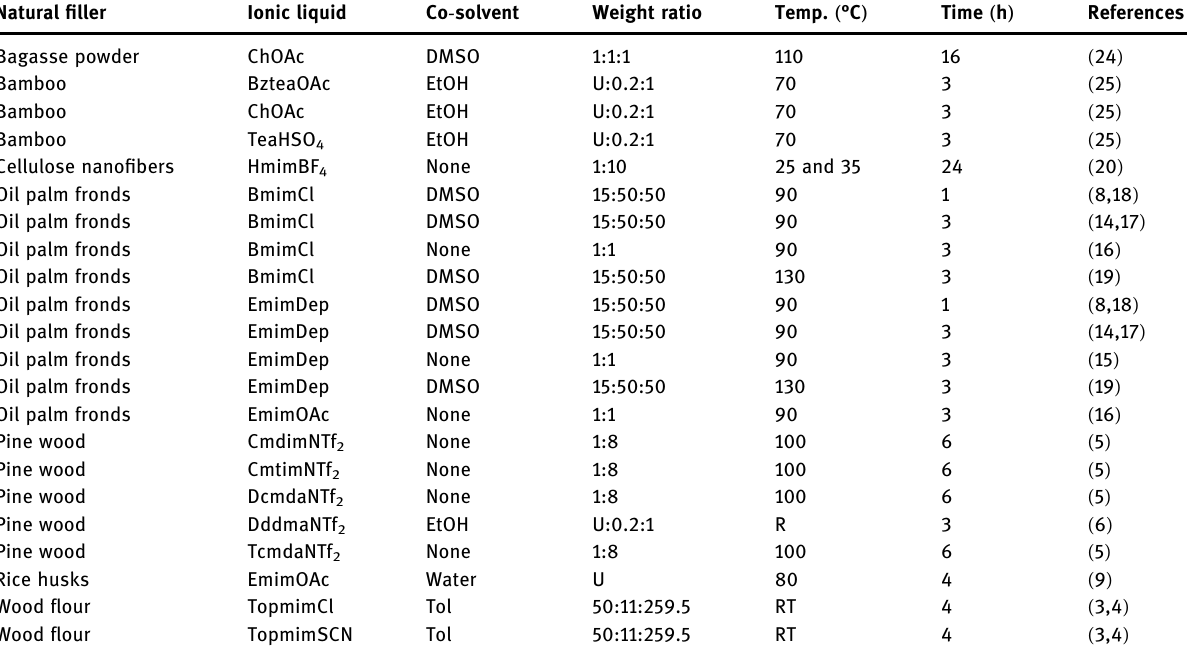
Table 3: Natural fi llers, ionic liquids, co - solvents, weight ratios, temperatures, and times employed for the pretreatment processes Natural fi ller